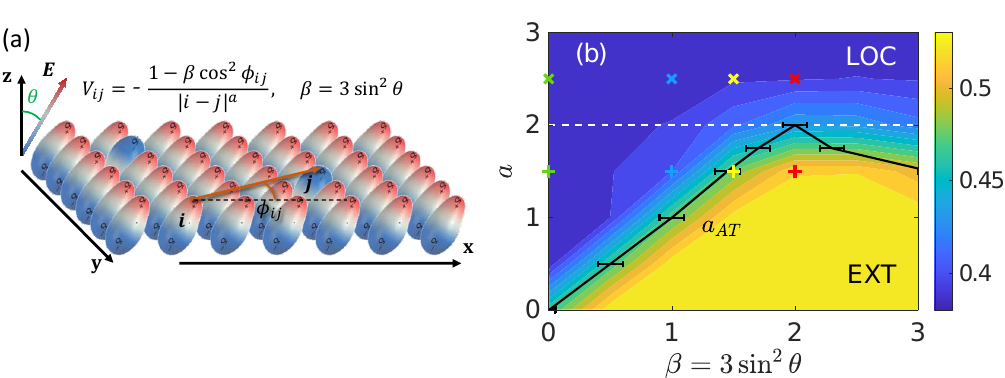
Figure 1: Model and phase diagram. (a) Two-dimensional (2d) lattice of quantum ) / | i − j | a , with few dipoles with dipole-dipole anisotropic interaction ( 1 − β cos 2 φ ij ) is the coordi- dipolar excitations (see dipoles down shown by blue tops). i = ( i , i x y nate vector of i th dipole, a > 0 is the generalized power-law decay exponent. The anisotropy parameter β = 3sin 2 θ is governed by the homogeneous tilt angle θ of all dipoles by the electric field E , tilted from the normal z -axis towards the lattice plane. φ is the angle between the spatial 2d vector i − j and the x -axis-aligned projection ij of the electric field to the plane. (b) The phase diagram of the anisotropic 2d dipole model with dilute excitations and the on-site disorder. The color plot shows the r - statistics at L = 200, averaged over disorder 〈 r 〉 ( E ) and then over the spectral bulk [ − W / 2, W / 2 ] , 〈 r 〉 , the black solid line a = a = min [ β , β/ ( β − 1 )] separates the AT localized ("LOC") phase, a > a , from the extended phase, a < a , while the black AT AT error bars correspond to these transition points, extracted from its finite-size scaling, Fig. 3. According to the analysis, the energy-resolved r -statistics 〈 r 〉 ( E ) is homoge- neous across the spectral bulk away from the critical point (see Fig. 2). Thus, the finite-size analysis is done on the spectral-averaged 〈 r 〉 and the crossing point of the finite-size curves occurs at the critical value 〈 r 〉 (cid:39) 0.47. The selected points with symbols " + " and " × " of the same colors (used in further figures) indicate the duality of power-law localization of wave functions for a < d = 2 and a > d